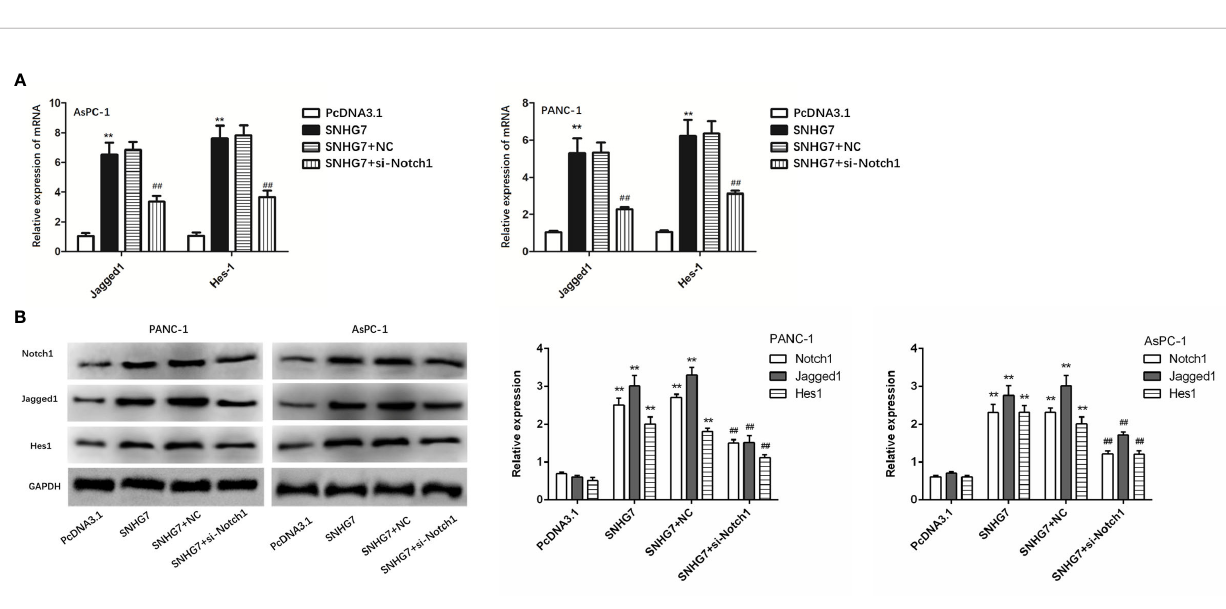
FIGURE 7 | MSC-induced SNHG7 facilitate the stemness and Fol fi rinox resistance through the Notch1/Jagged1/Hes-1 signaling pathway in pancreatic cancer. (A, B) The expressions of the Notch1/Jagged1/Hes-1 signaling pathway related mRNA and proteins were determined by qRT-PCR and Western blot assays. **P < 0.01 (compared control with pcDNA3.1), ## P < 0.01 (compared SNHG7+NC with